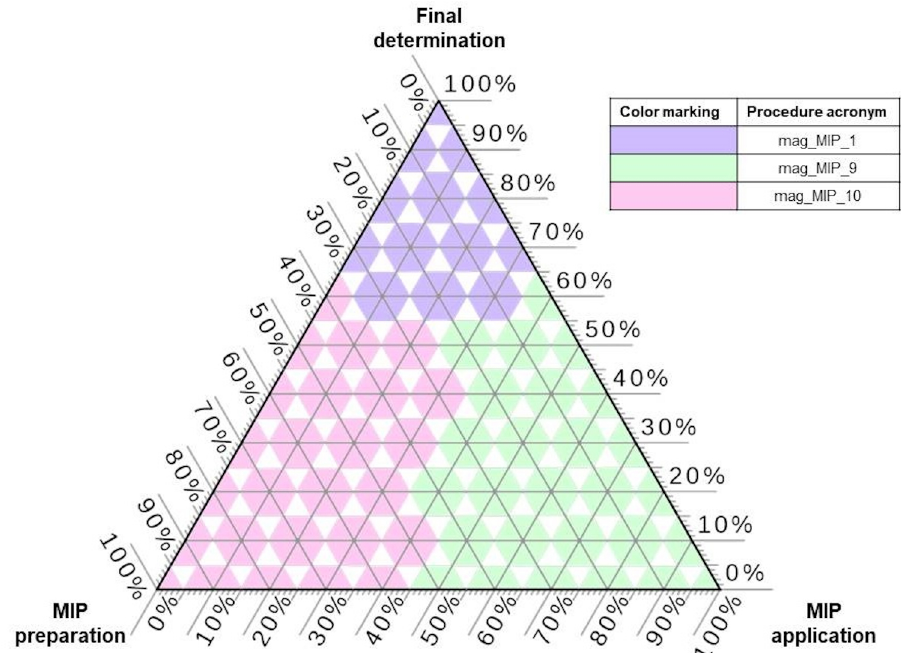
Figure 6. The winning procedures based on mag-MIPs according to TOPSIS rankings for different weights